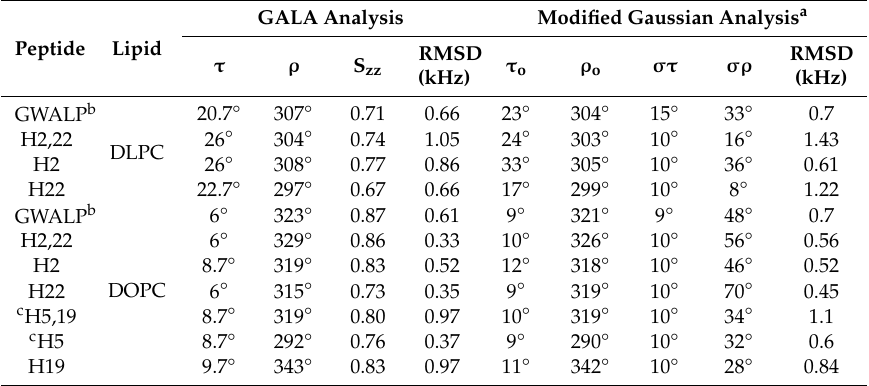
Table 3. Semistatic GALA and Modified Gaussian analysis results for transmembrane helix orientations of histidine-containing peptides of the GWALP23 family.